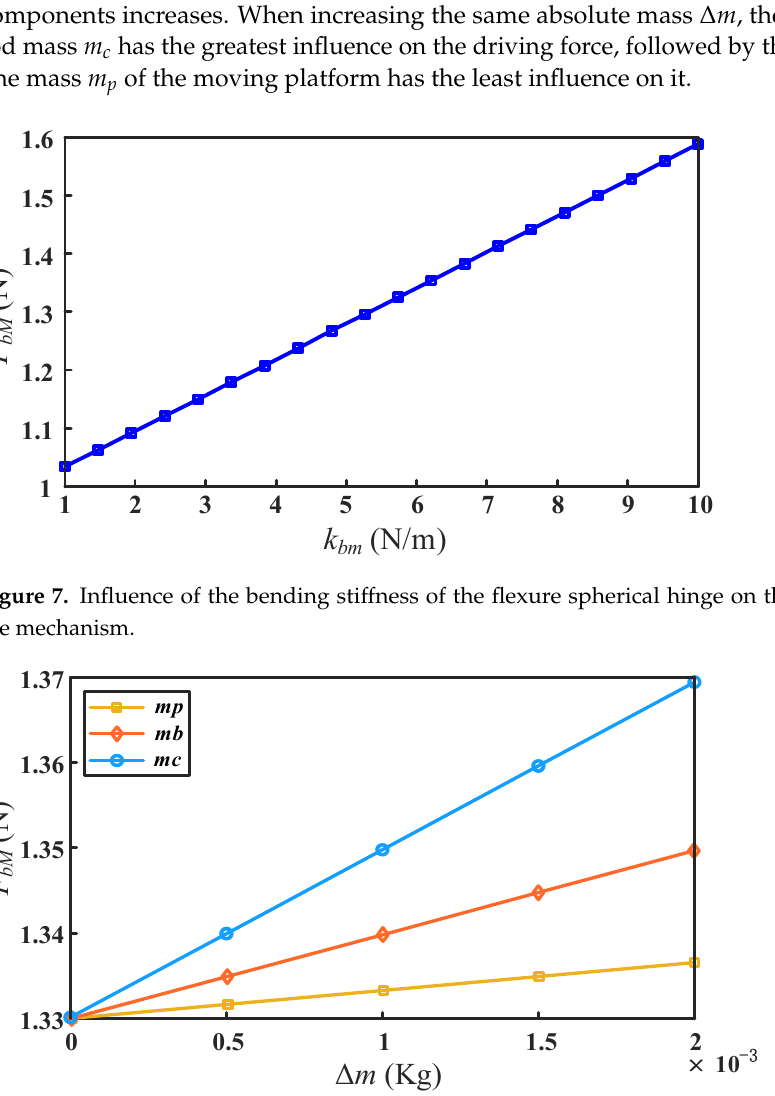
Figure 8. Influence of absolute mass change of different components on driving force.